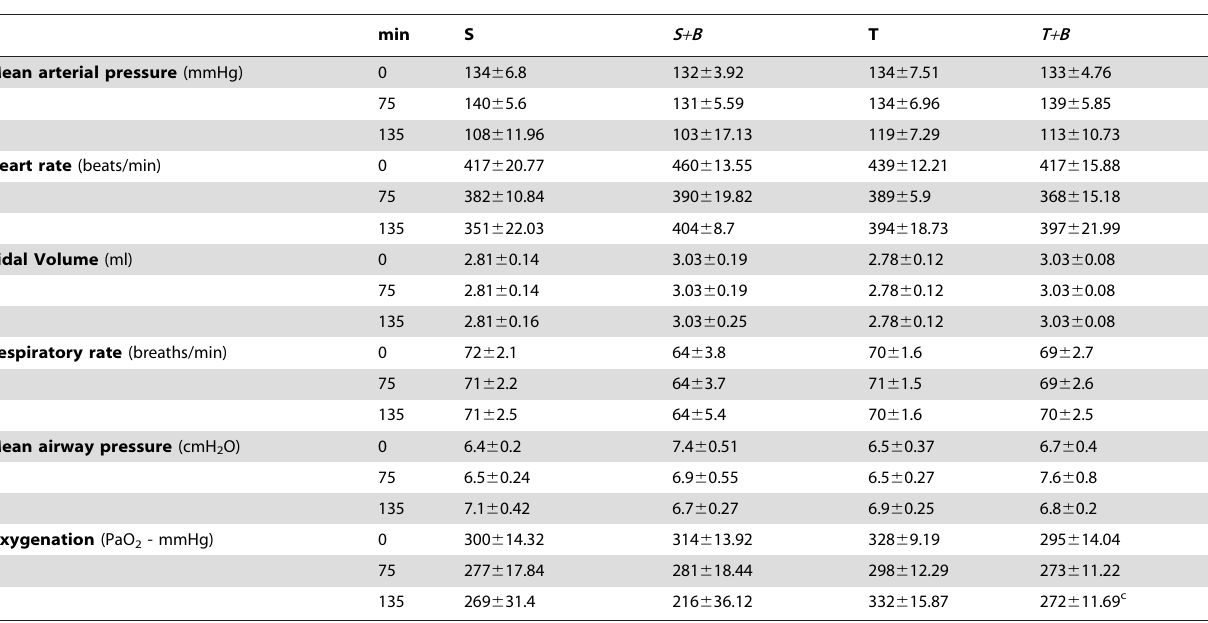
Table 2. Hemodynamic and respiratory variables.